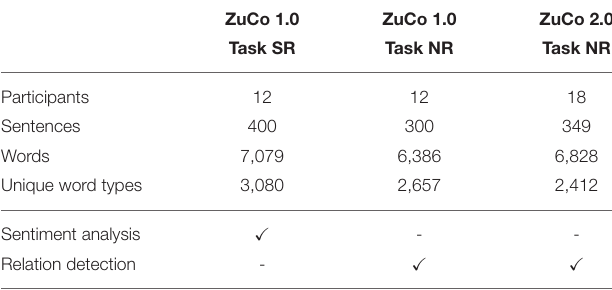
TABLE 1 | Details about the ZuCo tasks used in this paper.